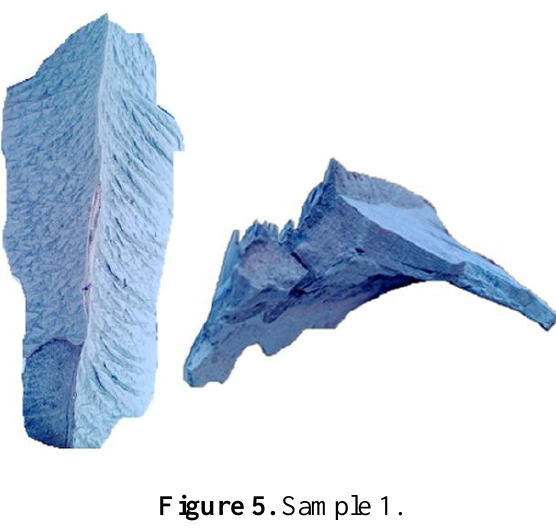
Figure 5. Sample